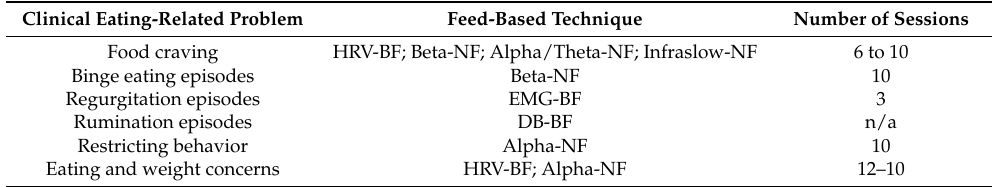
Table 2. Usefulness of feedback-based techniques for the treatment of dysfunctional eating behaviors. Clinical Eating-Related Problem Feed-Based Technique Number of Sessions Food craving 6 to 10 Binge eating episodes Beta-NF 10 Regurgitation episodes EMG-BF 3 Rumination episodes DB-BF n/a Restricting behavior Alpha-NF 10 Eating and weight